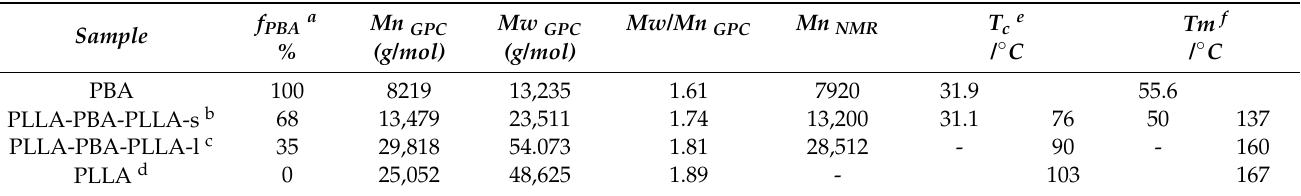
Table 1. Volume fraction, molecular weight, crystallization temperature, and melting temperature of PBA and PLLA, and within PLLA-PBA-PLLA